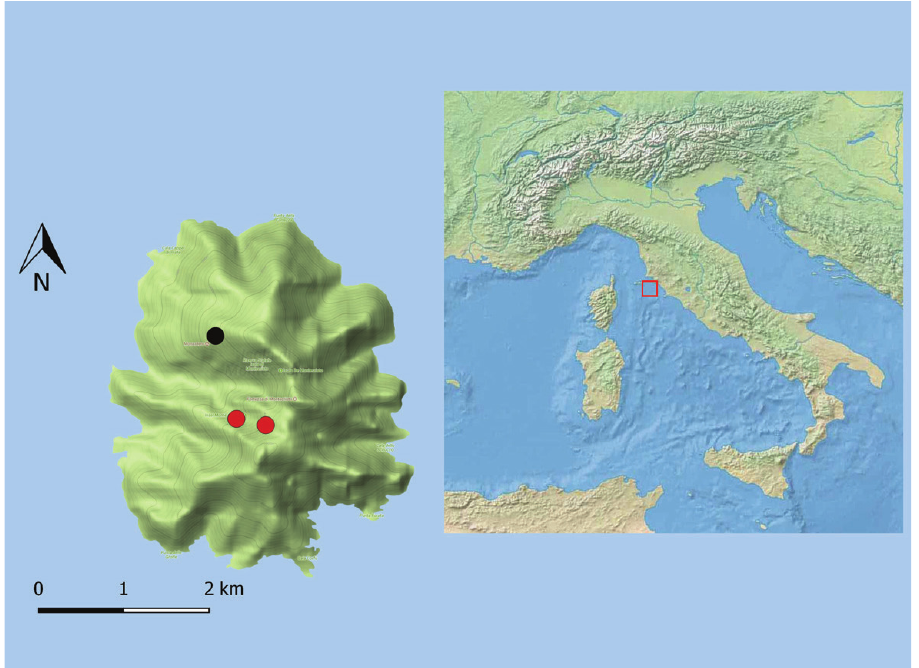
Figure 4. Geographic range and distribution map of Saxifraga montis-christi . The red points mark the current localities of occurrence; the black point indicate the historical